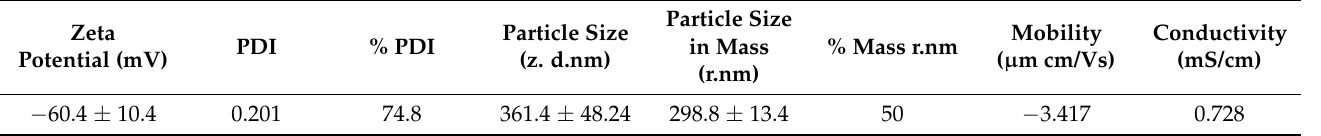
Table 1. Physical characterization of lyophilized recombinant HBsAg-loaded docosahexaenoic acid